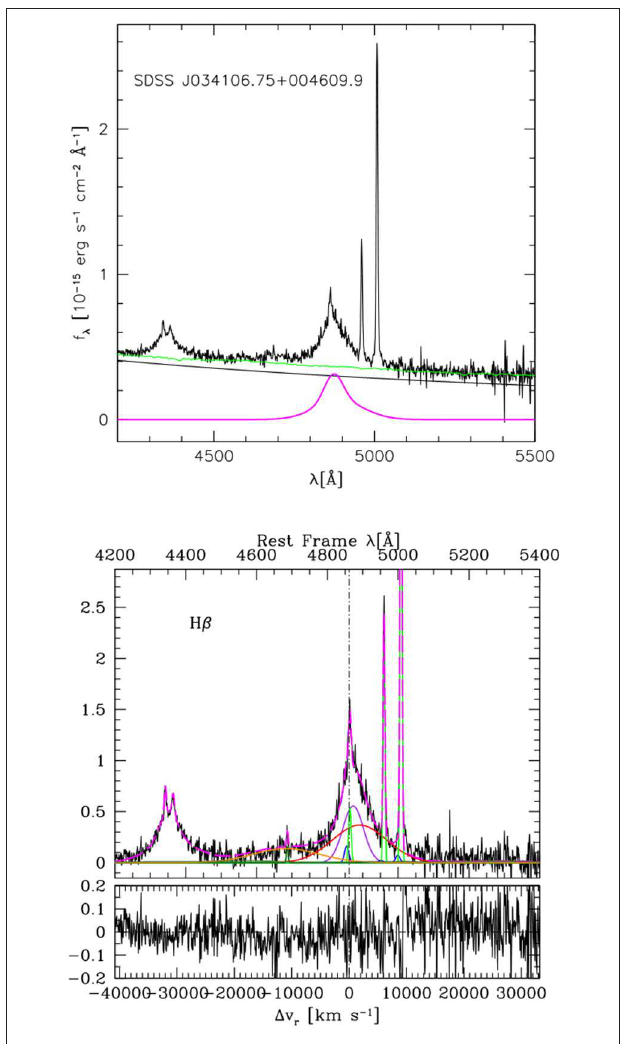
FIGURE 4 | Top: The H β spectral range of source SDSS J034106.75 004609.9. Abscissa in rest-frame wavelength in Å, ordinate in + specific flux in units of 10 − 15 ergs s − 1 cm − 2 Å − 1 . The black line traces the featureless continuum; the green line traces the total continuum that includes a contribution from the host galaxy. There is no detectable Fe II emission. The magenta line traces the cleaned H β broad profile. Bottom: H β profile analysis. The excess on the blue side of H β (orange line) can be explained by significant H e II λ 4686 VBC emission. H β and H γ are consistently fit with the same BC and VBC parameters [the BC (magenta) and VBC (red) decomposition is shown for H β only]. Narrow lines ( [O III ] λλ 4959,5007 and H β NC ) have been modeled by a core and a (fainter) blue shifted component (blue line). The abscissæ are rest frame wavelength in Å radial velocity displacement from H β narrow component in km s − 1 (lower panel), ordinate is specific flux normalized to f λ (5100 Å) 3.44 10 − 16 ergs s − 1 cm − 2 Å − 1 . The ≈ · lower panel yields the residuals defined as observed minus model spectrum.